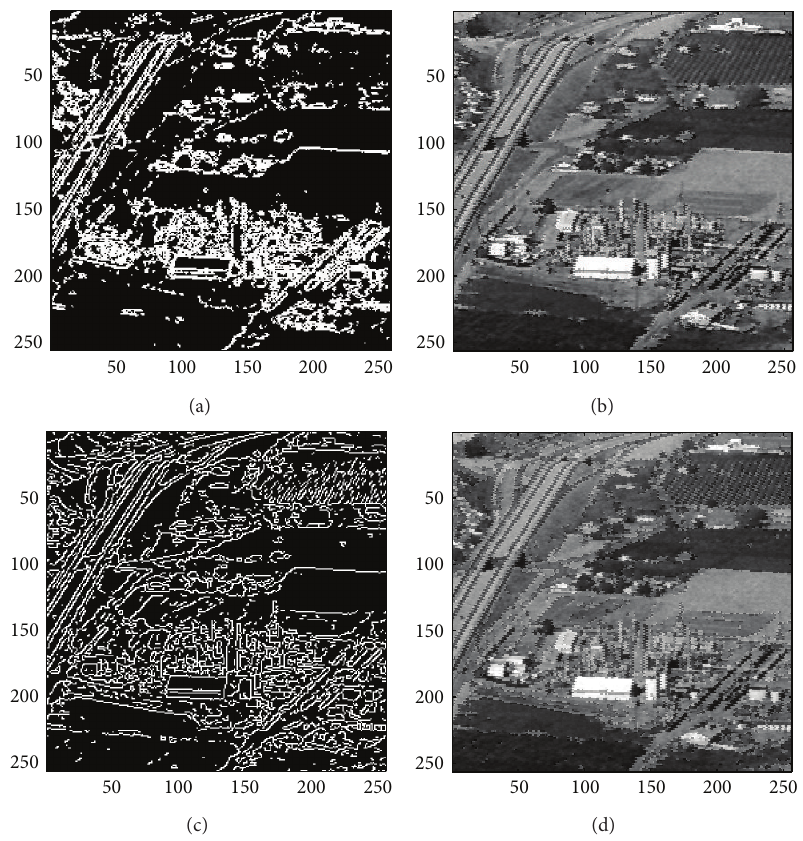
= 18 in the image “Chemicalplant.” (b) Result by HVD with scaling factor 𝑠 = 1.0 . (c) Edges Figure 9: (a) Edges detected by HVD with 𝜃 eth detected by Canny operator in the image “Chemicalplant.” (d) Result by Canny operator with scaling factor 𝑠 = 1.0